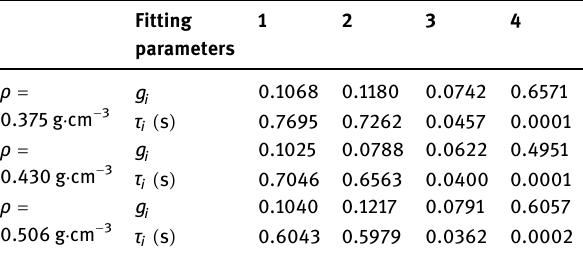
Table 5: Fitting parameters of constitutive